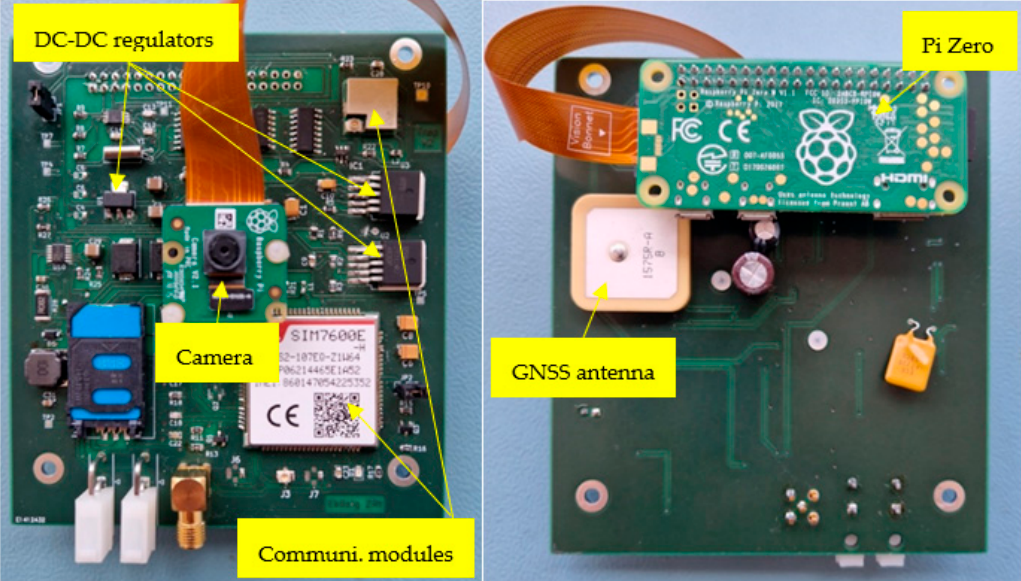
Figure 1. Front ( left ) and back ( right ) sides of the sensing device.